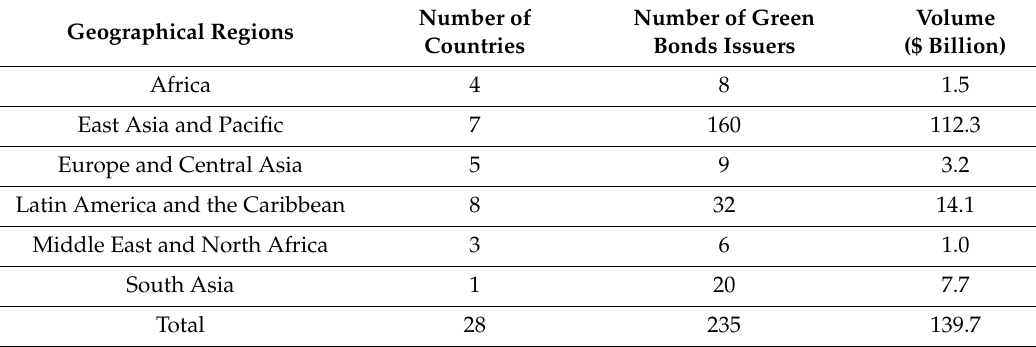
Table 1. Green bonds issued by di ff erent regions from 2012 to 2018. Number of Number of Green Volume Geographical Regions Countries Bonds Issuers ($ Billion) Africa 4 8 1.5 East Asia and Pacific 7 160 112.3 Europe and Central Asia 5 9 3.2 Latin America and the Caribbean 8 32 14.1 Middle East and North Africa 3 6 1.0 South Asia 1 20 7.7 Total 28 235